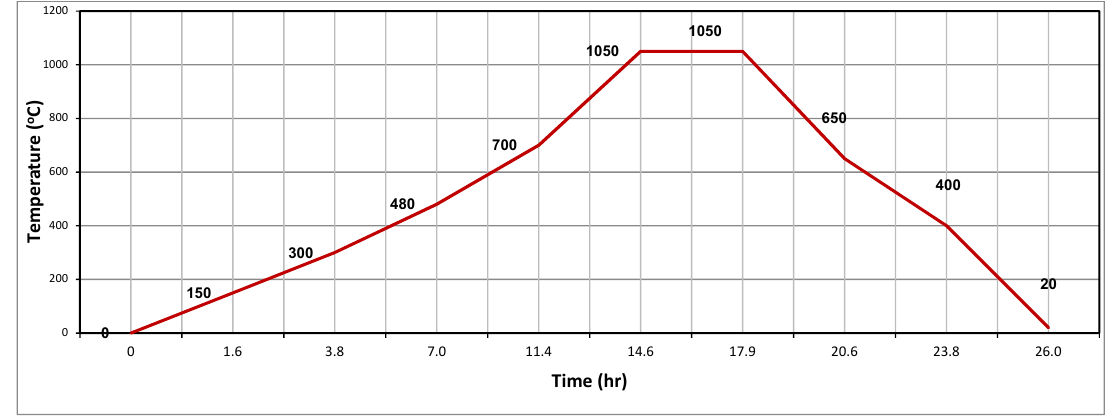
Figure A3. Firing cycle of DM, HM, and SM. Table A1. The concentrations of soluble salts in DM, HM, and SM